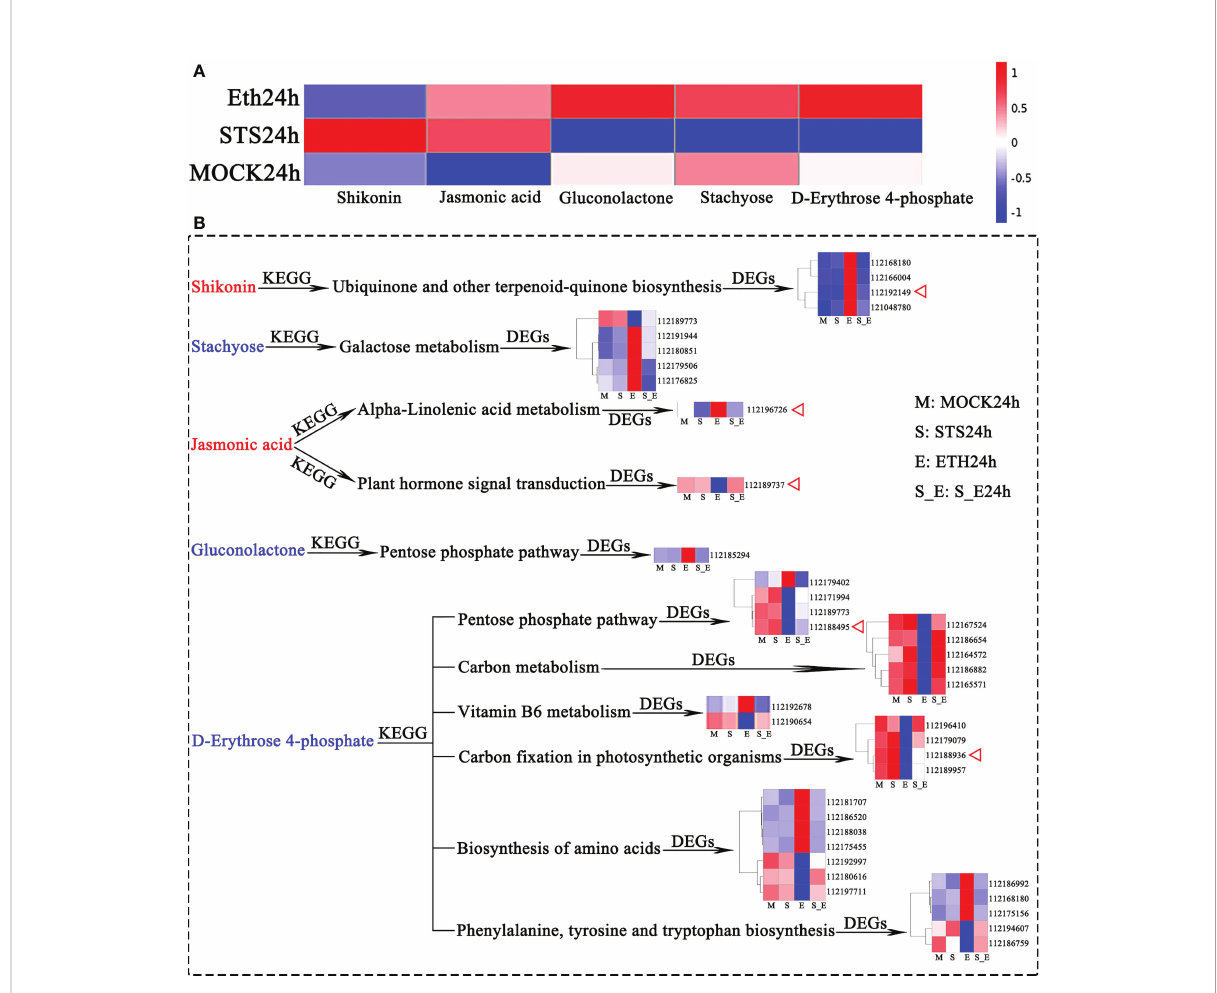
FIGURE 8 Analysis of DAMs and associated DEGs affected by STS. (A) Accumulation patterns of fi ve metabolites in different samples. (B) DEGs associated with 5 DAMs. Red letter represented up-regulated metabolites affected by STS, blue letter represented down-regulated metabolites affected by STS. DEGs are shown for gene